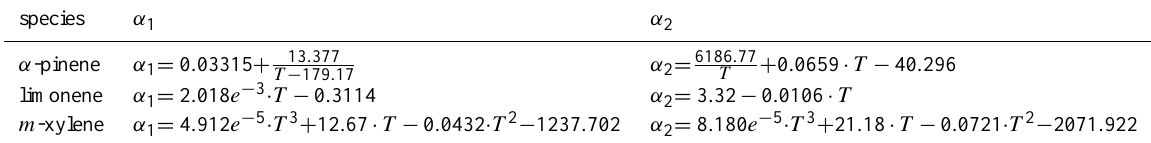
Table 3a. The unified temperature parameterized functions α(T ) for mass stoichiometric coefficient ( α) . species α 1 α 2 α -pinene α 1 = 0 . 03315 + 13 . 377 T − 179 . 17 limonene